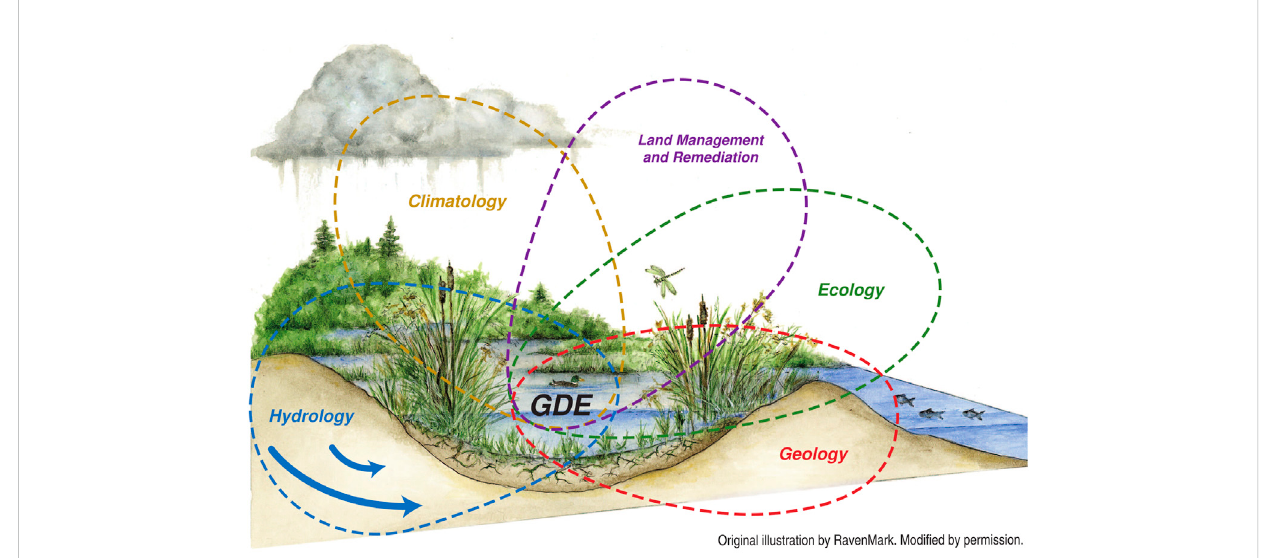
FIGURE 1 GDE-related research and its position among various areas of expertise. Original illustration (Living Observatory, 2020) by RavenMark, modi fi ed by C.E. Hatch by permission. © Creative